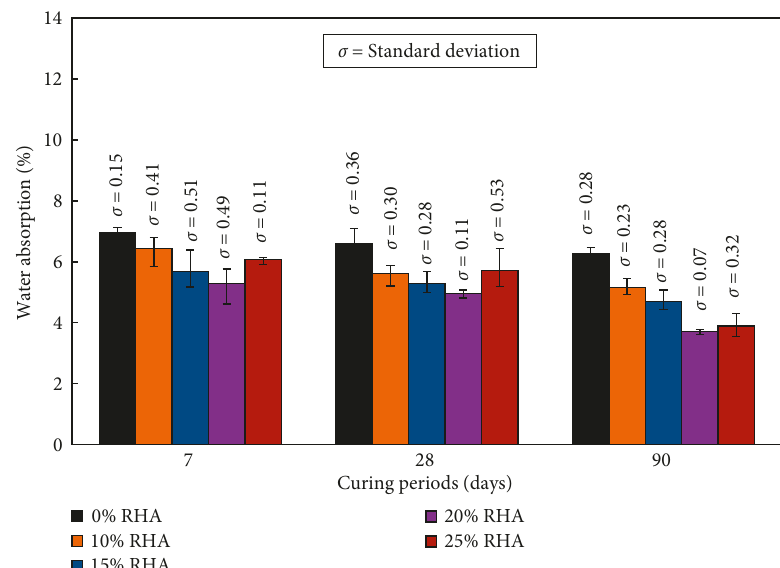
Figure 5: Water absorption capacity of RBAC at 7, 28, and 90 days of